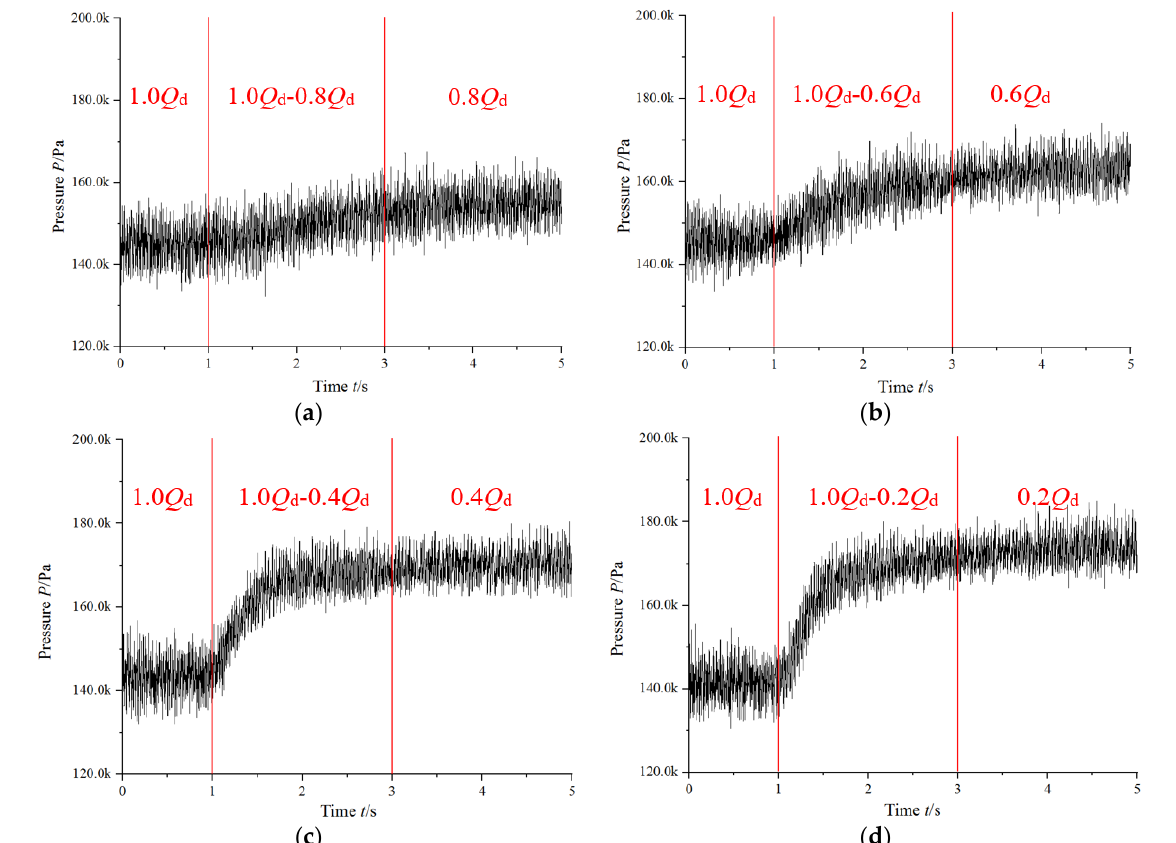
Figure 4. The time domain of pressure fluctuation at P1. ( a ) S1, ( b ) S2, ( c ) S3 and ( d ) S4.